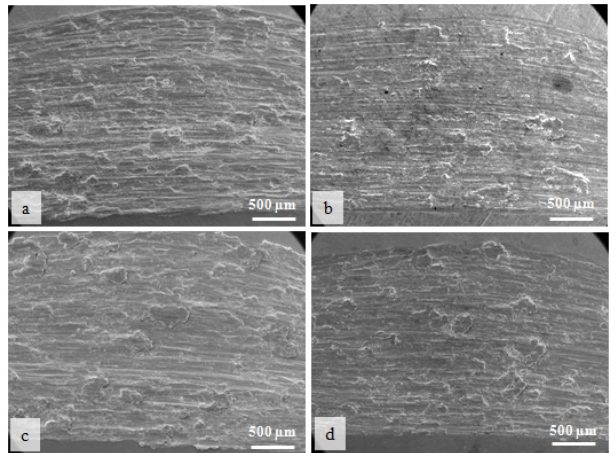
Figure 8. SEM images of the wear tracks for Monel K500 in ( a ) as-weld and ( b ) annealed and aged at 610 °C conditions and for FM60 in ( c ) as-weld and ( d ) annealed and aged at 610 °C conditions for the torch travel speed of 500 mm/min.